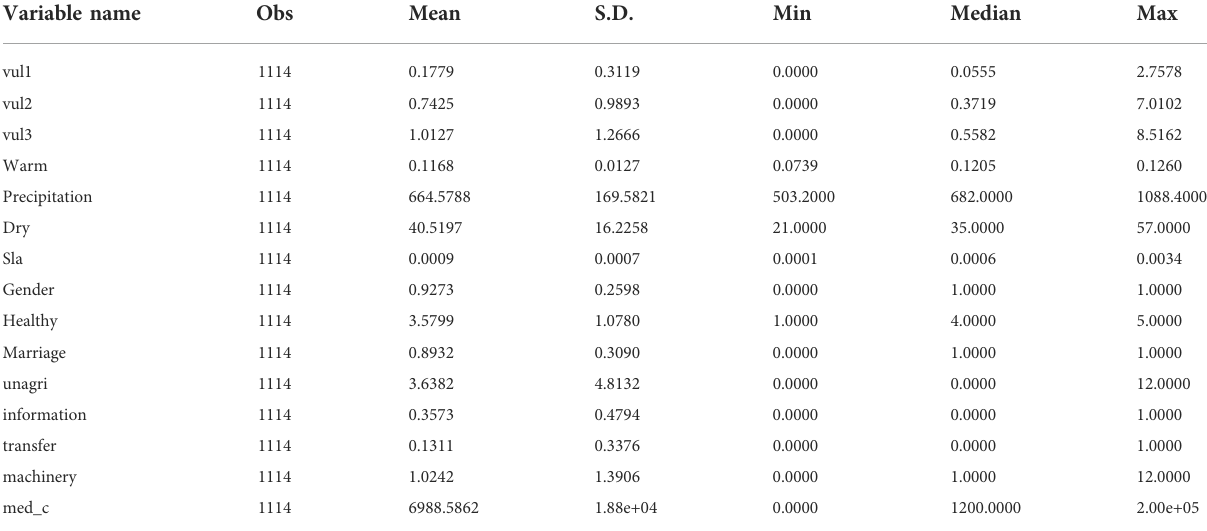
TABLE 4 Descriptive statistics of variables of